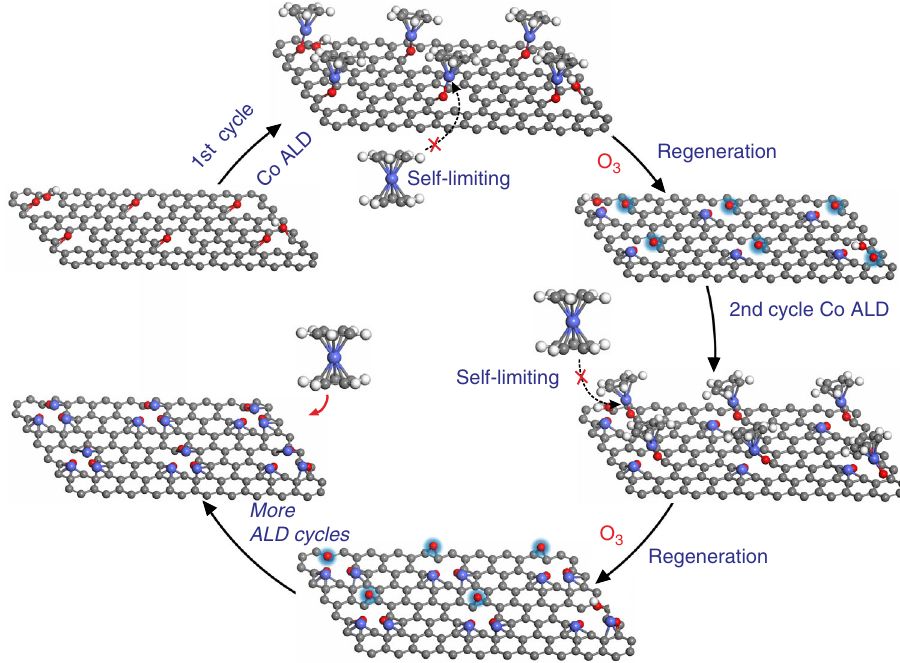
Fig. 1 Schematic illustration of the synthesis of Co 1 /G SACs with tuneable loadings. The fi rst cycle of Co ALD by an alternative exposure of the support to CoCp 2 vapor and O 3 gas at 150 °C; the second cycle of Co ALD on Co 1 /G to deposit another batch of Co atoms on the active sites created by O 3 treatment at 150 °C in the previous Co ALD cycle; more cycles of Co ALD results in a high loading of Co 1 SACs. The balls in gray, white, red, and blue represent carbon, hydrogen, oxygen, and cobalt,